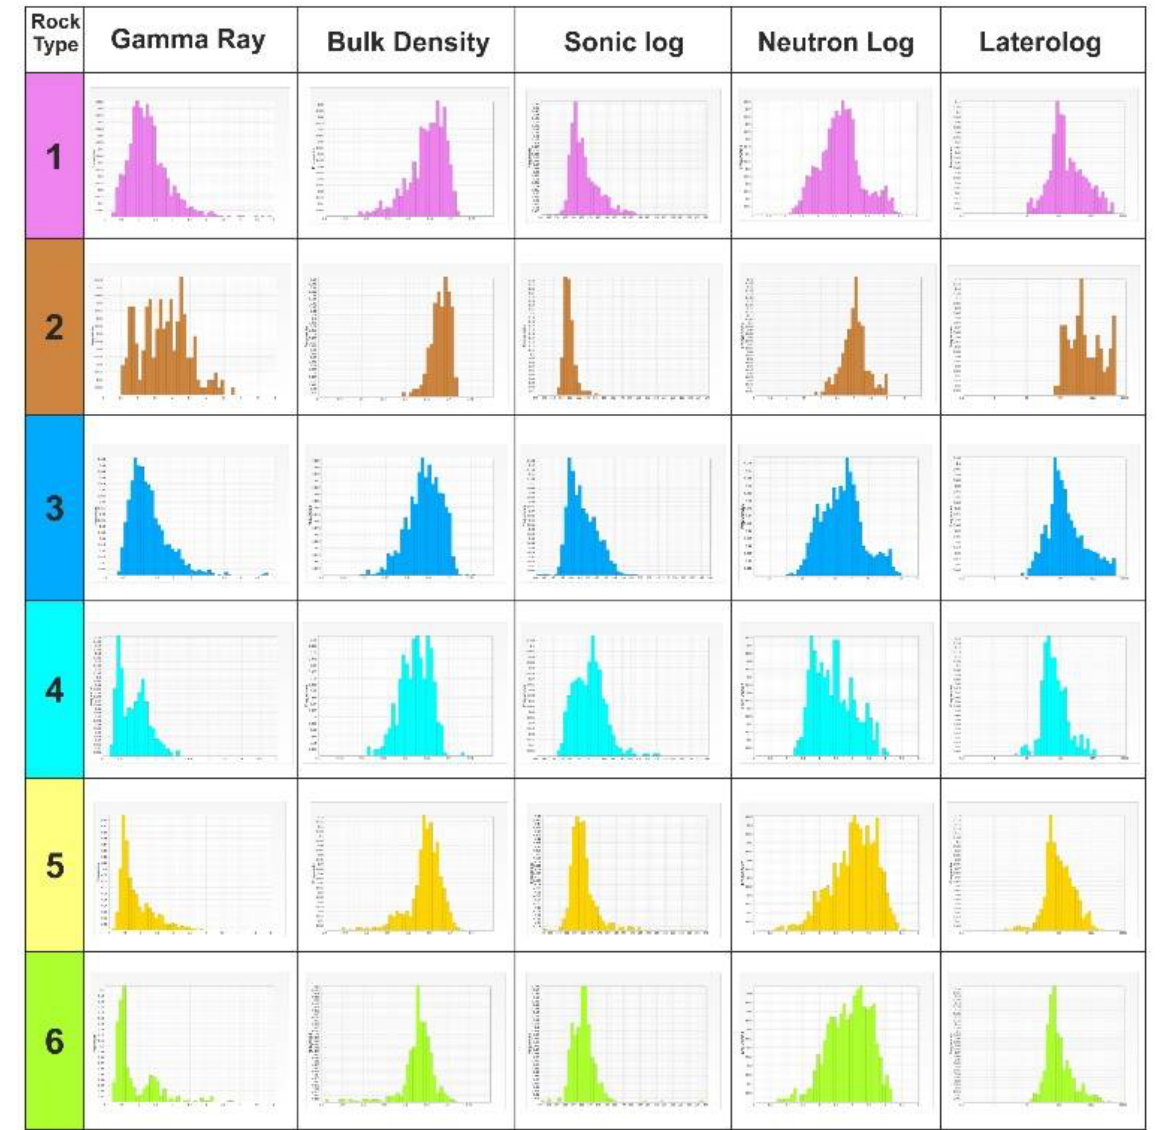
Figure 10. Histograms showing the distribution of the wireline log values: pink = lithofacies type 1, brown = lithofacies type 2, blue = lithofacies type 3, turquoise = lithofacies type 4, yellow = lithofacies type 5, and green = lithofacies type 6.